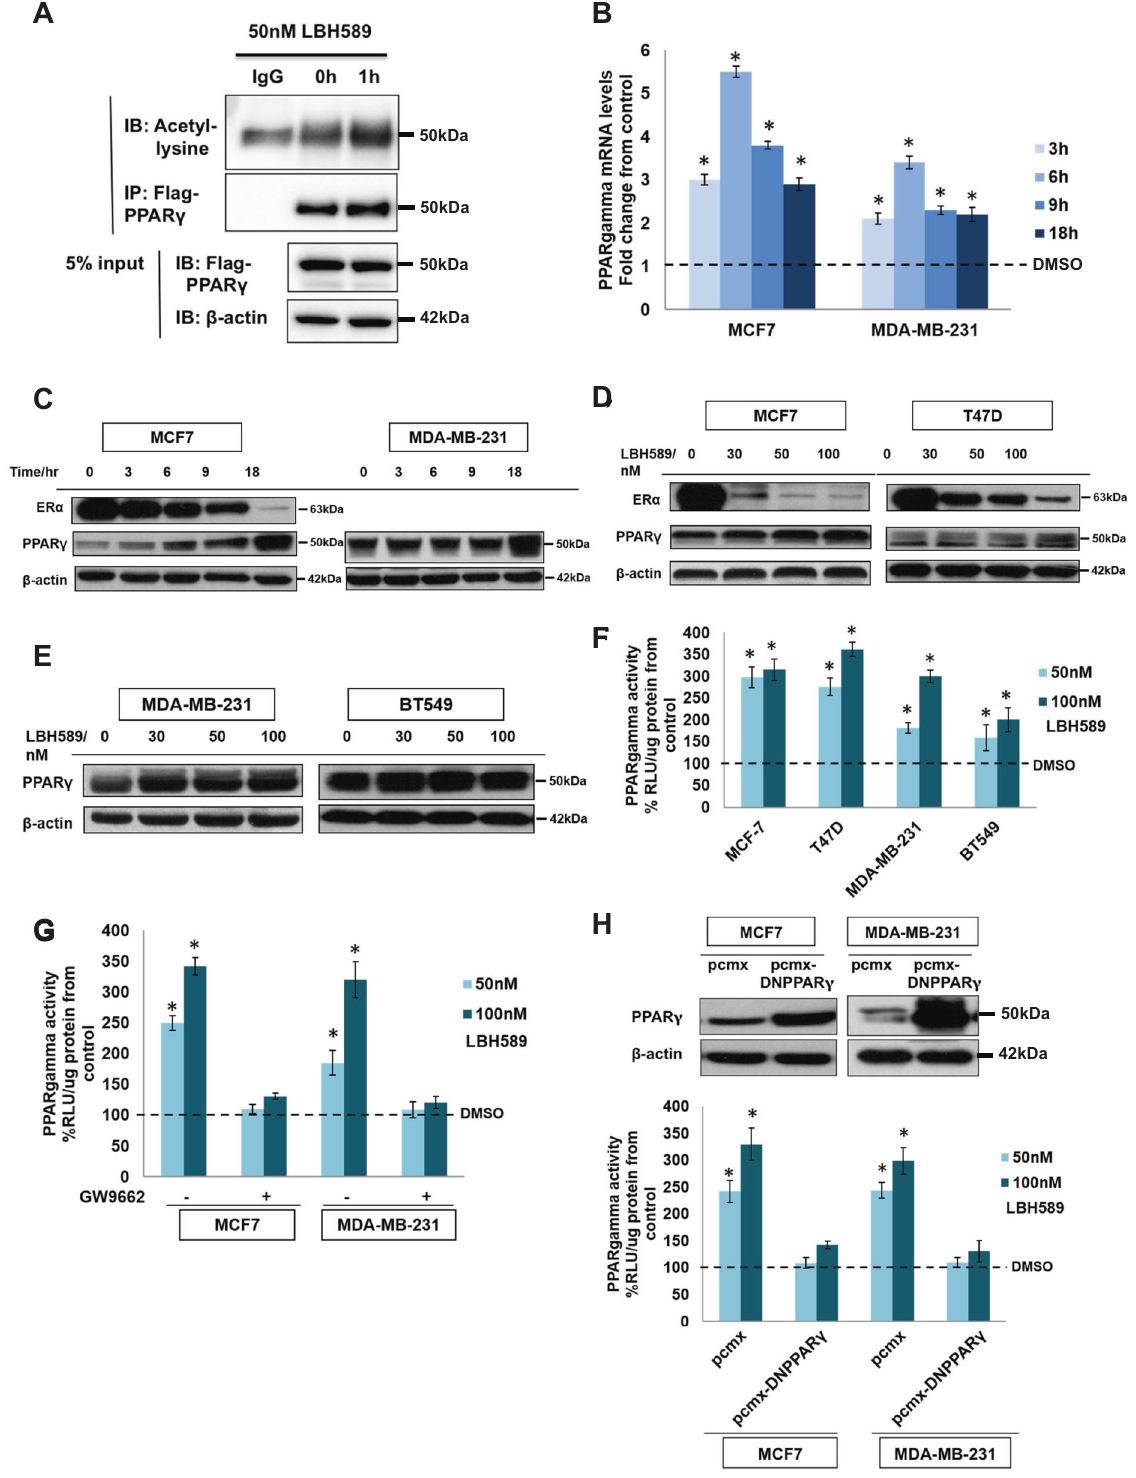
Synergistic effects of HDAC inhibitors and PPAR γ agonists against TNBC cells Our upstream analyses had indicated that TNBC tumor specimens expressed higher levels of HDACs which, in turn, curtails PPAR γ - mediated anticancer signaling pathways, suggesting that HDAC inhibition may be required to reverse the brakes on PPAR γ